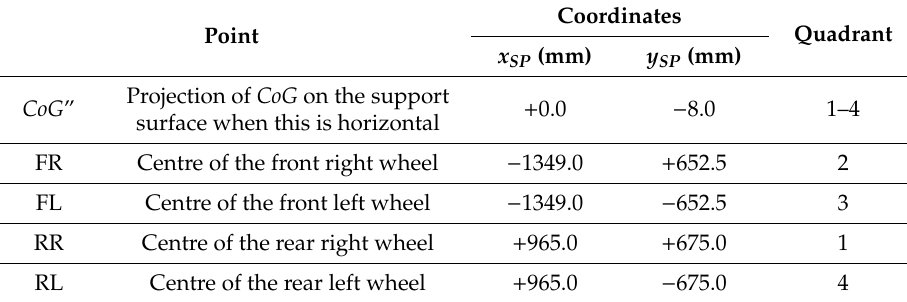
Table 3. Coordinates of the main points of the